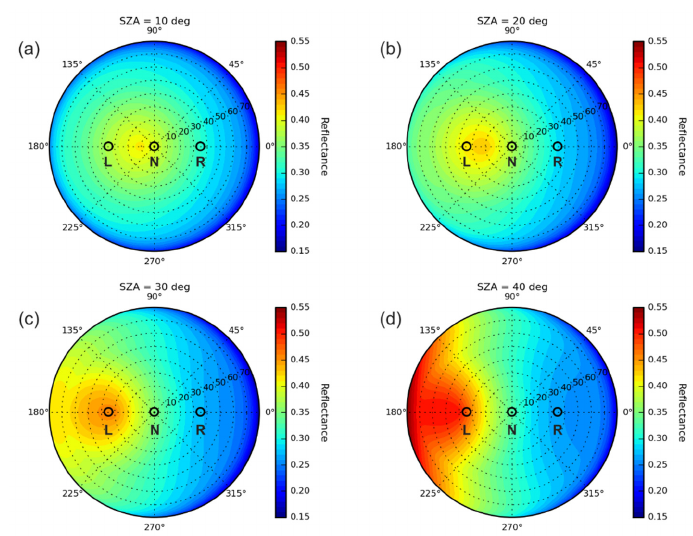
Figure 6. The figure shows Proba-V NIR band BRDF for ( a ) SZA = 10°, ( b ) SZA = 20°, ( c ) SZA = 30°, ( d ) SZA = 40°. Distance from the origin is the zenith angle, while azimuth angles span the polar plot plane. The VZA positions of the left (L), nadir (N) and right (R) cameras are shown in each plot with black circles. In the used convention, the SAA is 180°, the VAA spans 0–360°, i.e., the region with relative azimuth angle (RAA = SAA–VAA) < 90° corresponds to the backscattering, while RAA > 90° to the forward scattering directions. Note that the convention used here for VAA and SAA is different from the one reported in the operational products, although the relative position of the sun and viewing azimuth directions are preserved.